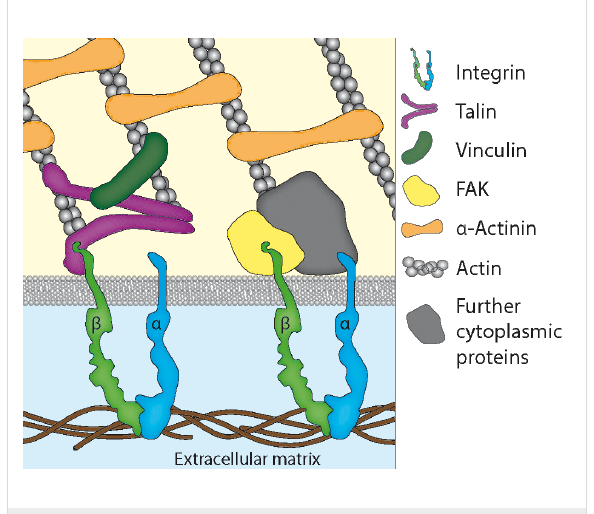
Figure 1: Schematic view of active integrin molecules linking the ECM to the actin cytoskeleton. The heads of the integrin molecules attach directly to their ligand molecules in the ECM; the intracellular tail of integrin binds to proteins like talin and FAK. On the intracellular side, active talin dimers also bind to filamentous actin. Other proteins like FAK form an indirect linkage to the actin cortex together with further cytoplasmic proteins. These intracellular anchor proteins, which include vinculin and α -actinin, help to regulate and reinforce the actin–integrin